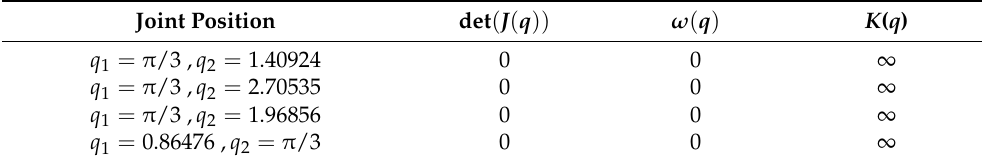
Table 4. det ( J ( q )) , ω ( q ) , and K ( q ) with singularity. Joint Position